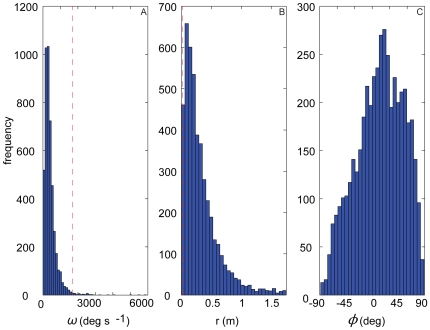
Histograms of turning flight performance.Plots show performance metrics related to turning: (A) turn rate (); (B) turn radius () for all <1.75 m; (C) elevation angle of centripetal acceleration vector (). Dashed lines represent one-tailed 99% confidence intervals. No confidence intervals are plotted for  since the data are constrained to ±90°.